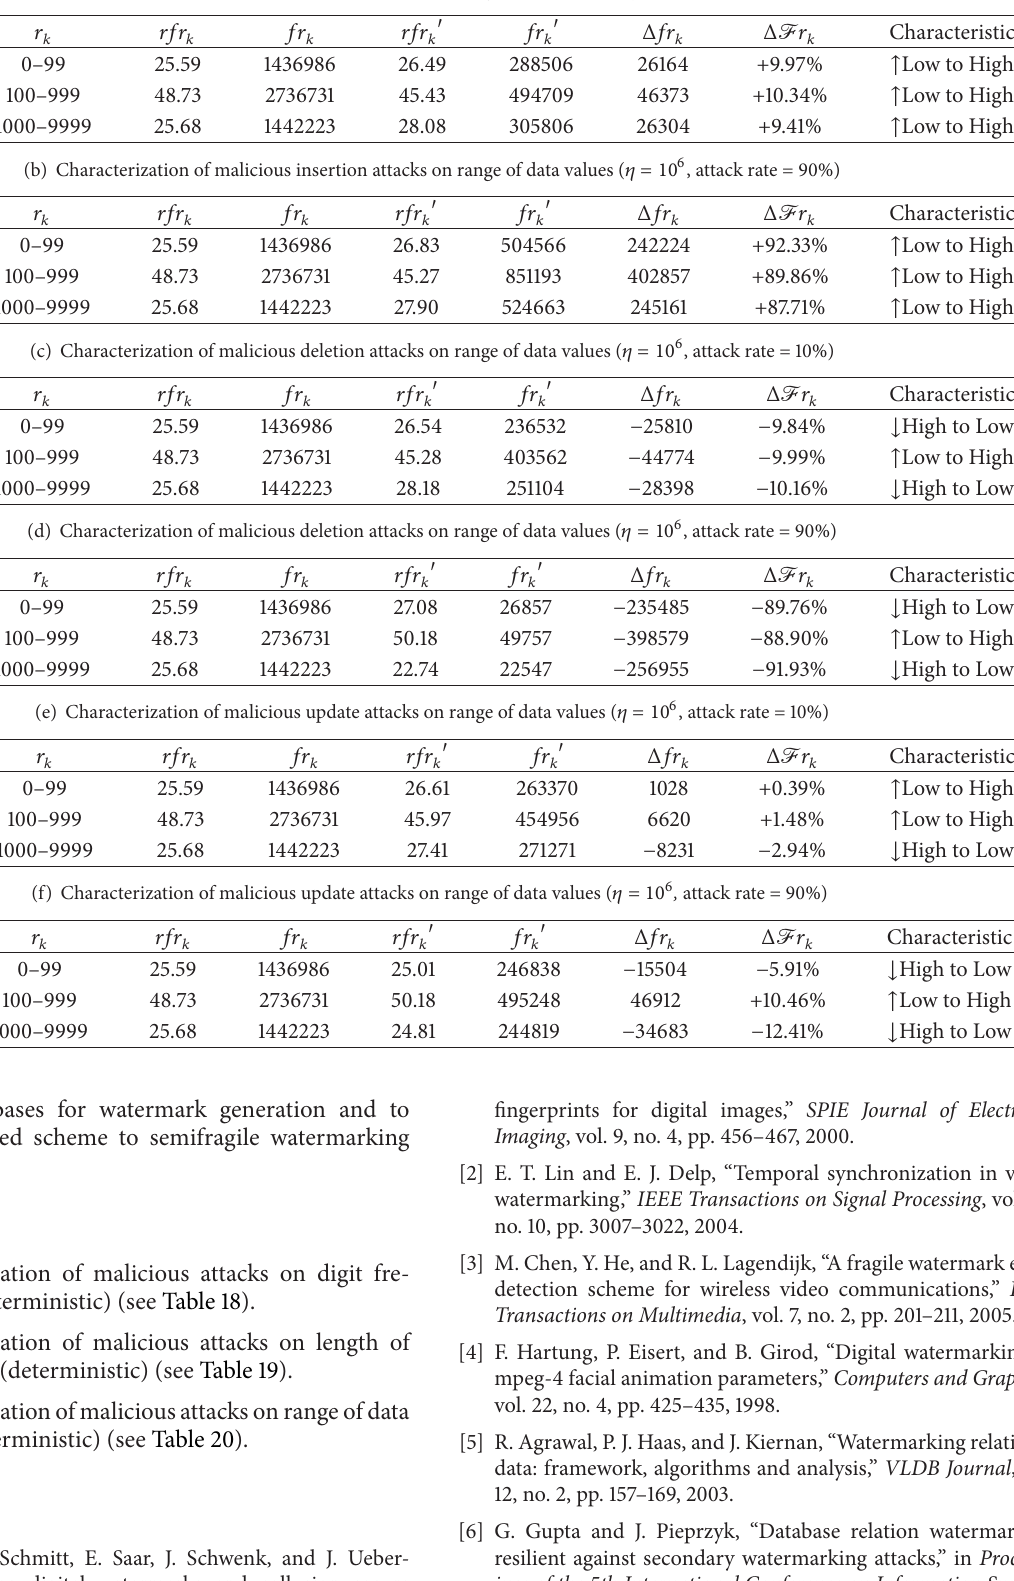
Table 20: Characterization of malicious attacks on range of data values